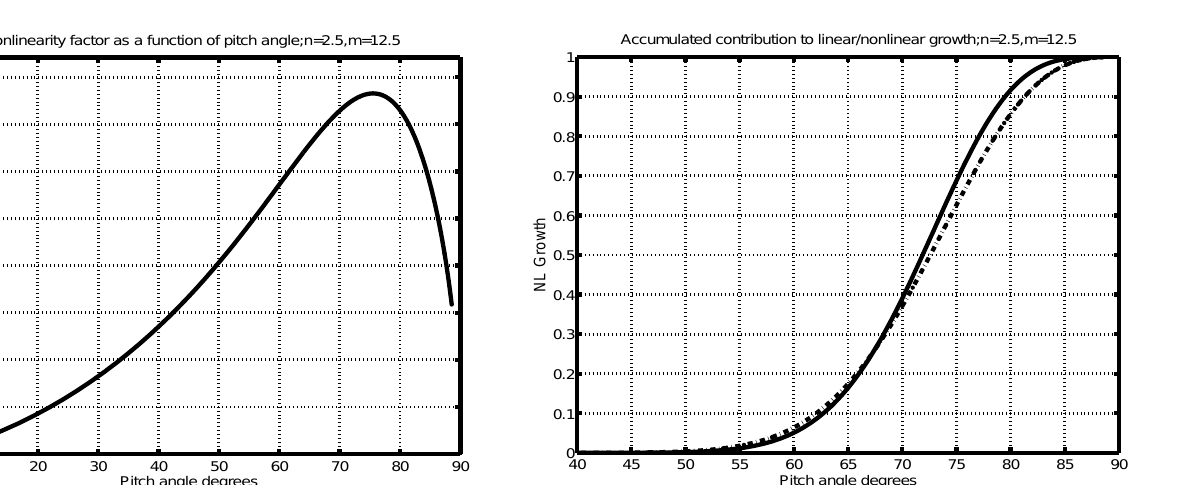
Fig. 3. The nonlinearity factor η , as a function of pitch angle. This is approximately equal to the maximum number of trapping oscil- lations of resonant particles in the equatorial zone.